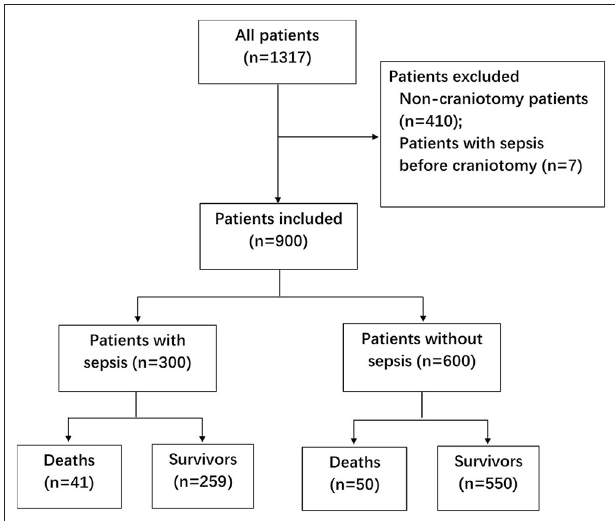
FIGURE 1 | Flow diagram of enrolled patients. ICU, intensive care unit; LOS, length of stay.